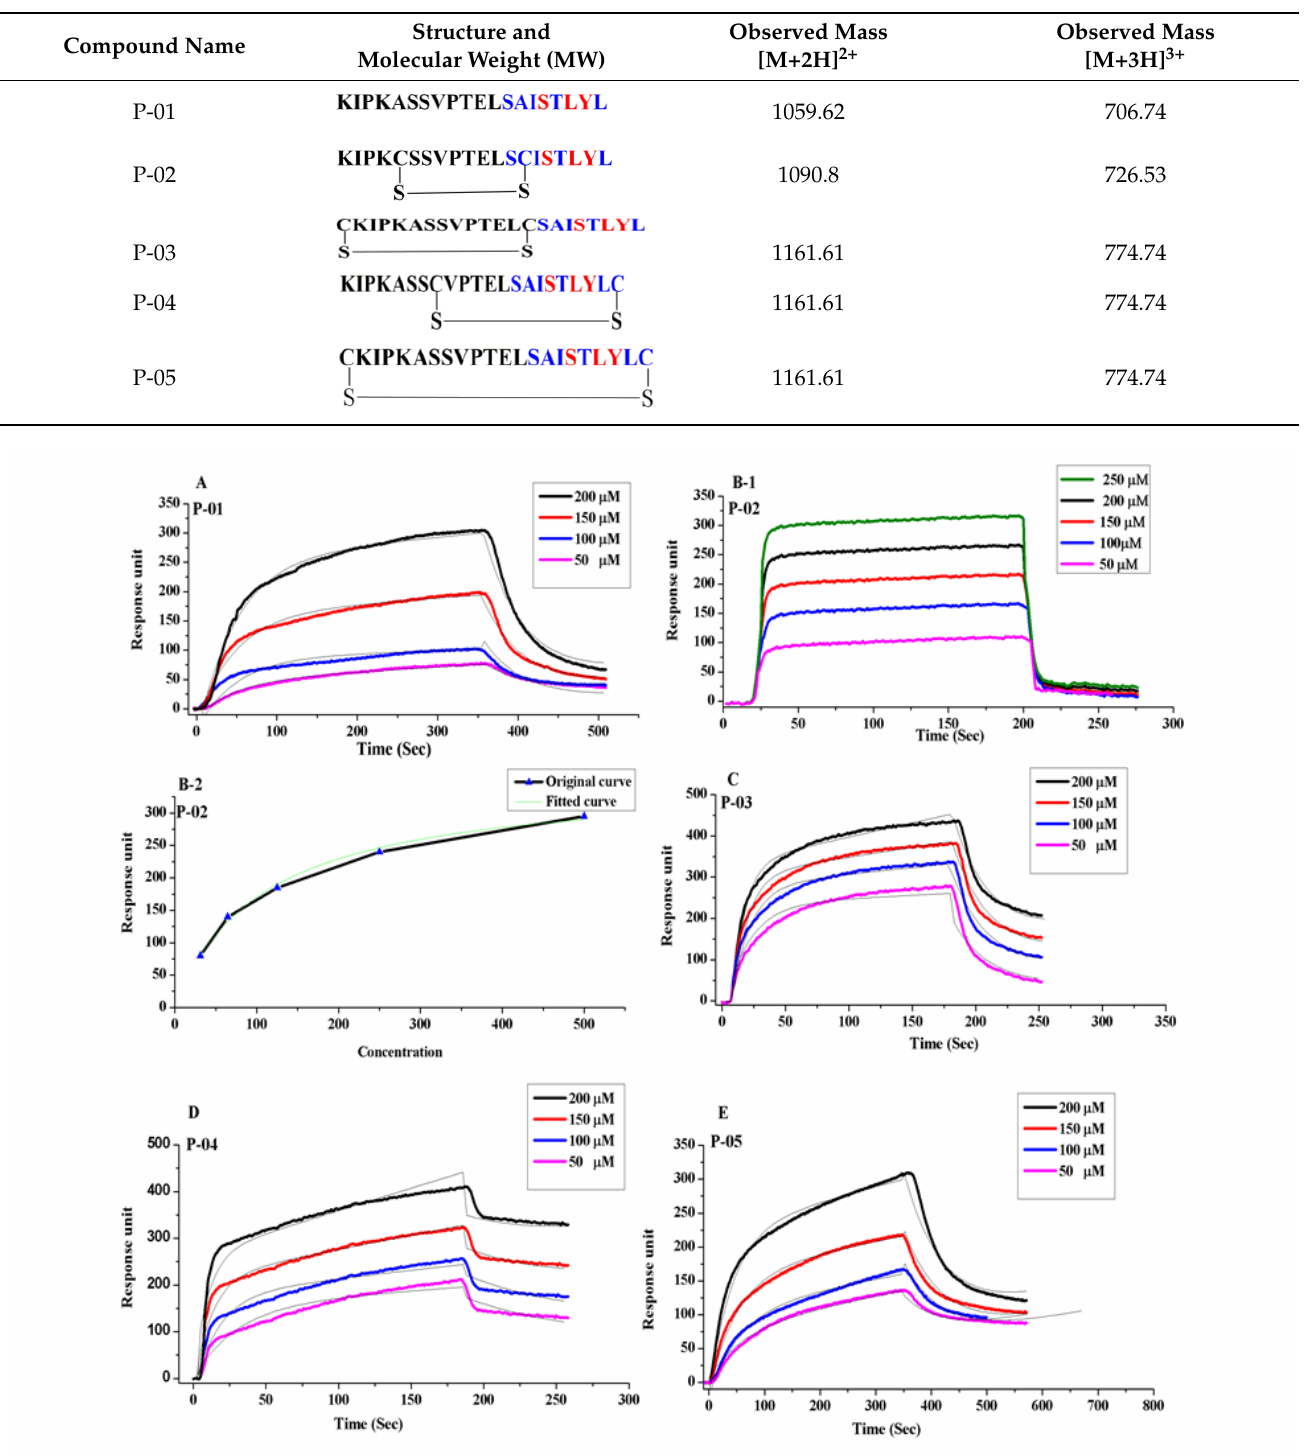
Table 1. The molecular weight of the bone morphogenetic protein 2 (BMP-2) linear and cyclic peptides.